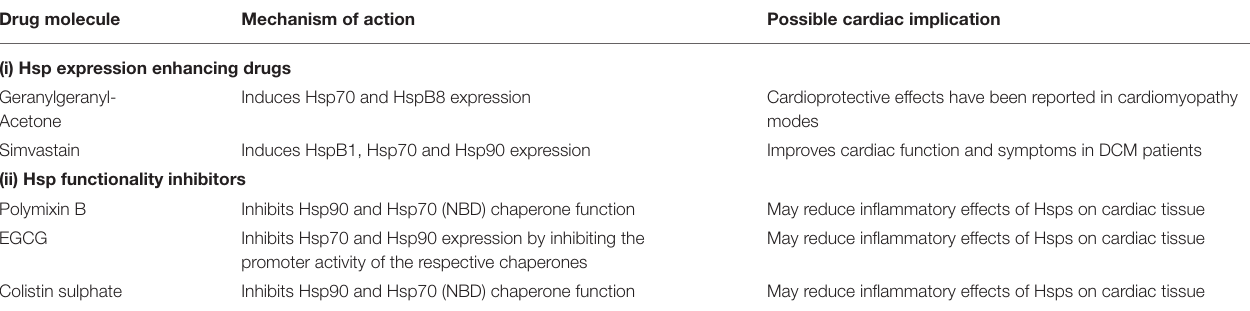
TABLE 3 | Hsp-centred drug modulation strategies in novel PPCM drug design. Drug molecule Mechanism of